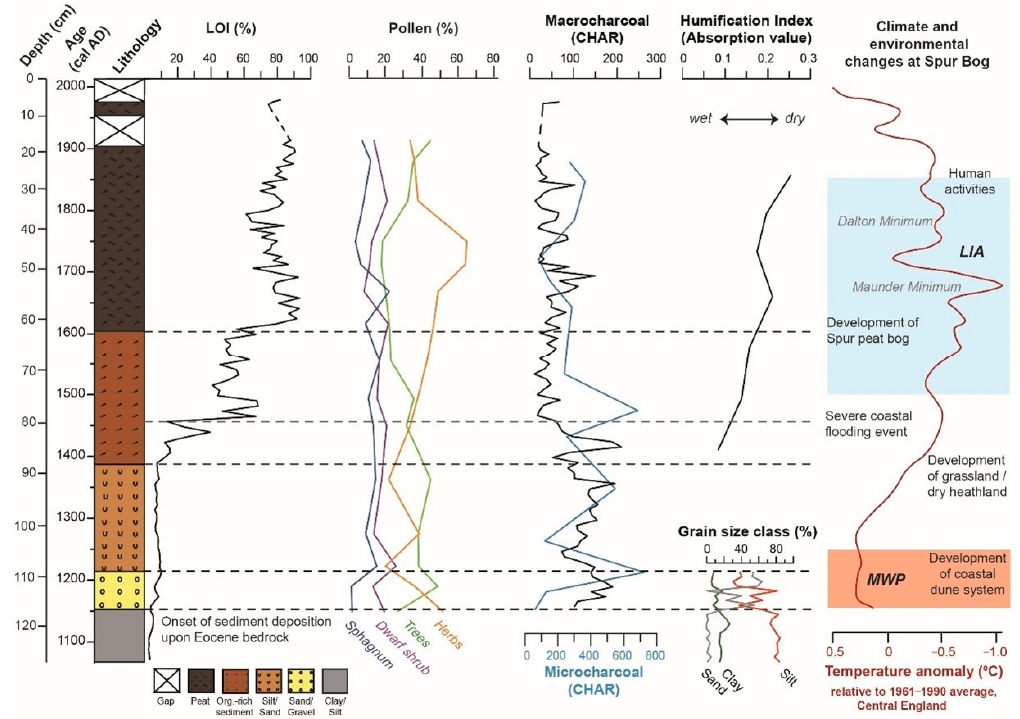
Figure 7. Lithology, loss of ignition (LOI), selected pollen species/groups data, charcoal, the humi- fication index, and grain size data of Spur Bog core SPUR-A on a time scale and interpretation of multi-proxy data with regard to climatic and environmental changes (for detailed references, see Section 4.2). Dotted lines indicate major lithological changes. Abbreviations: LIA = Little Ice Age; MWP = Medieval Warm Period.